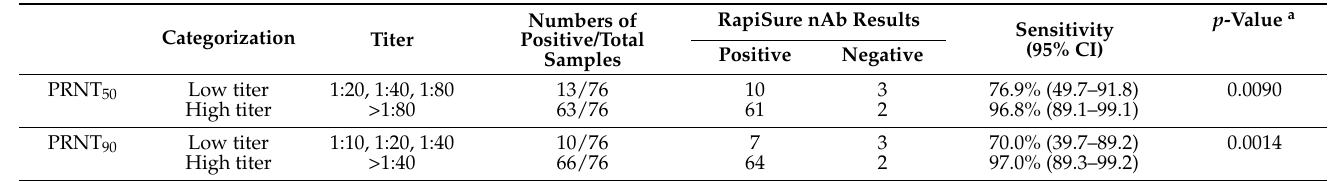
Table 4. Results of the RapiSure COVID-19 Neutralizing Ab Test according to low- and high-titer groups in the PRNT